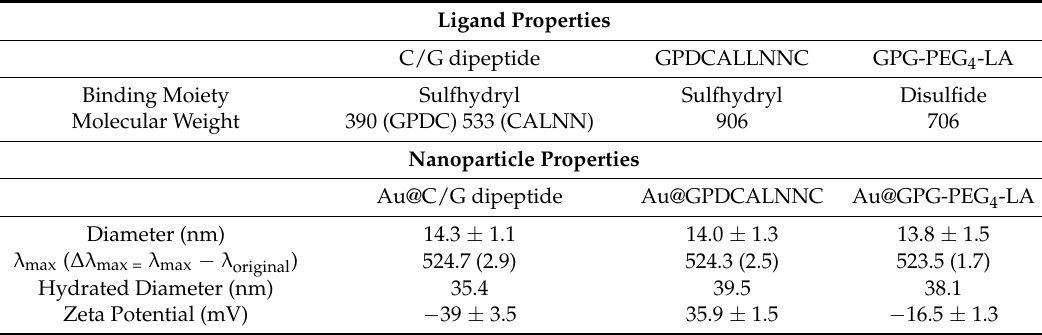
Table 2. Summary of ligand and functionalized gold nanoparticle